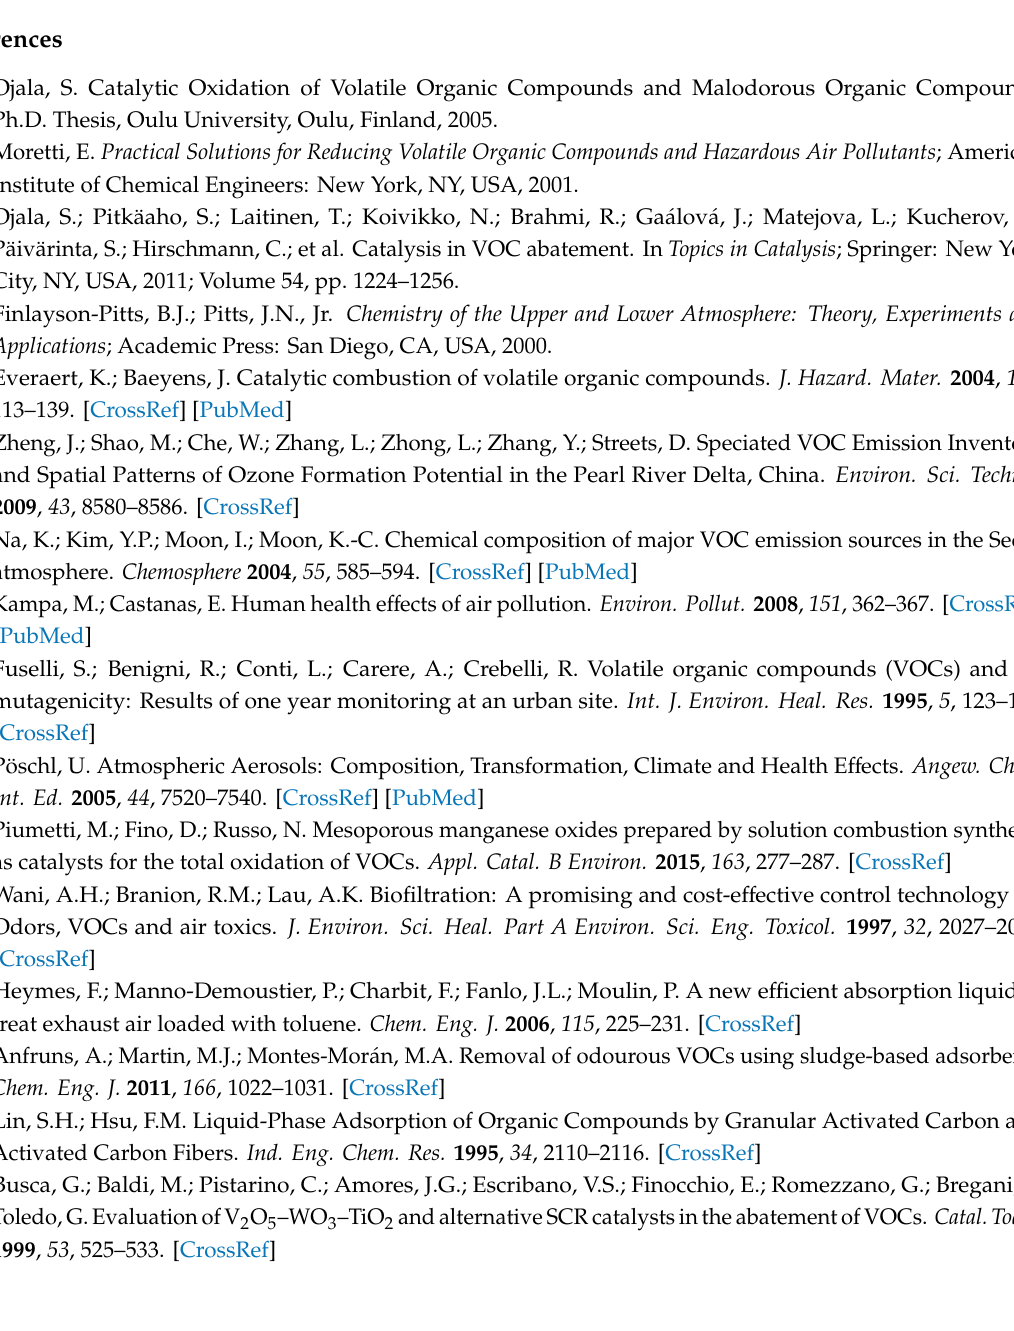
Figure S1: Schematic diagram of the apparatus used for the photocatalytic